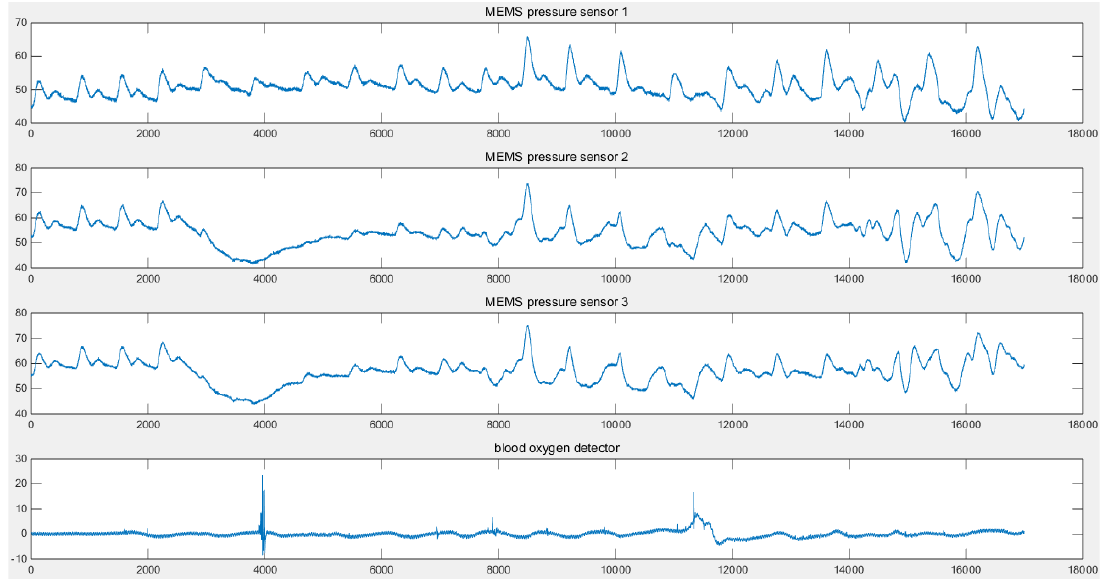
Figure 10. Waveforms of a multi-sensor pulse wave monitoring system.